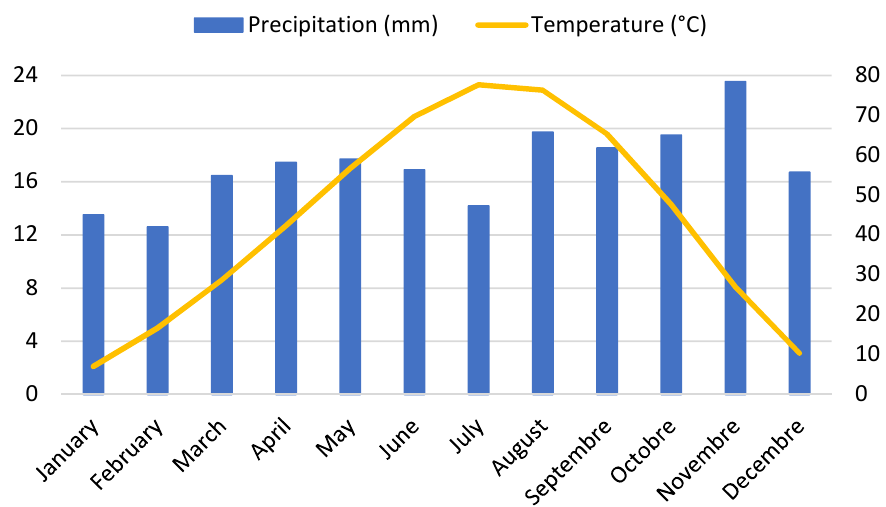
Figure 2. Historic average of precipitation and temperature in Ferrara (1961–1990) (after [24]).